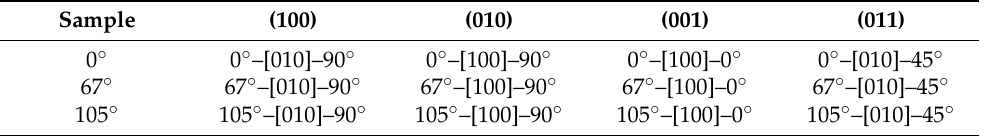
Table 2. The test matrix for each sample, where the orientation is listed, shows the plane normal to the compression direction. The notation for the orientation is hatch angle–rotation direction– rotation degree.